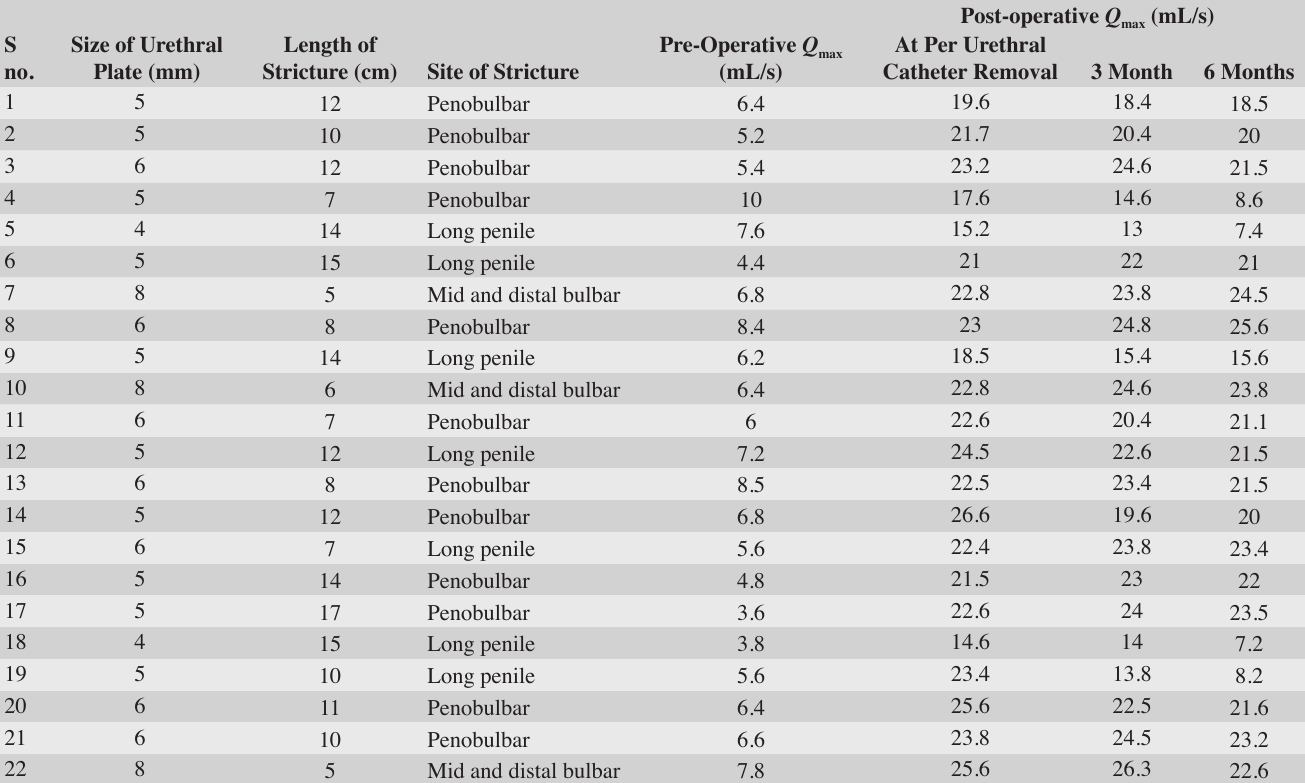
Table 2. Change in Q After Per Urethral Catheter Removal, 3 Months and 6 Months in Relation to Length of max Stricture and Size of Urethral Plate